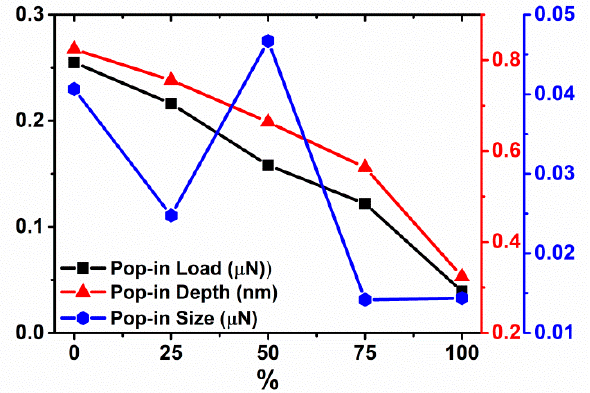
Figure 18. Pop-in load, depth and size vs. prestrain for Cu sample under reloading, indented with tip radius R = 7.5 nm.